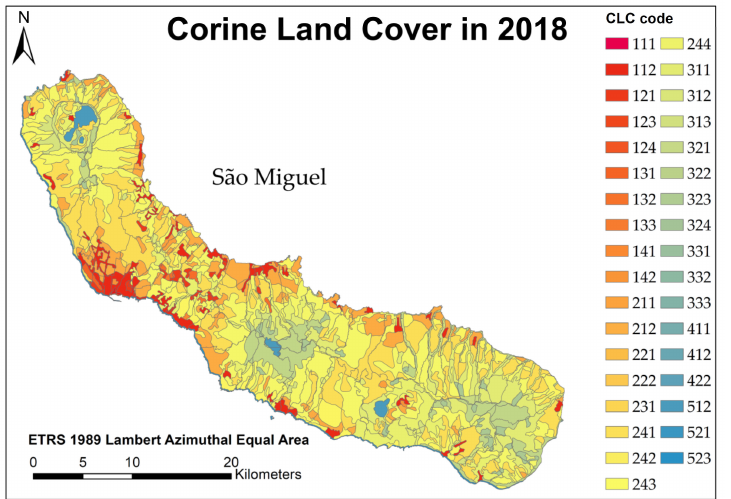
Figure 8. Thematic cartography regarding the land-use changes in the Azores Archipelago Eastern group in the year